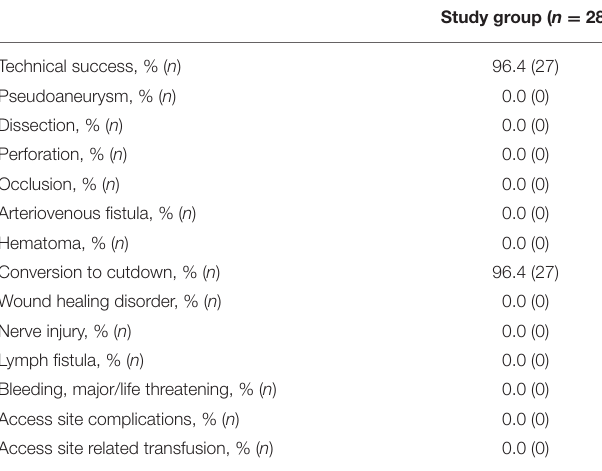
TABLE 4 | Vascular closure device outcome parameter at 30